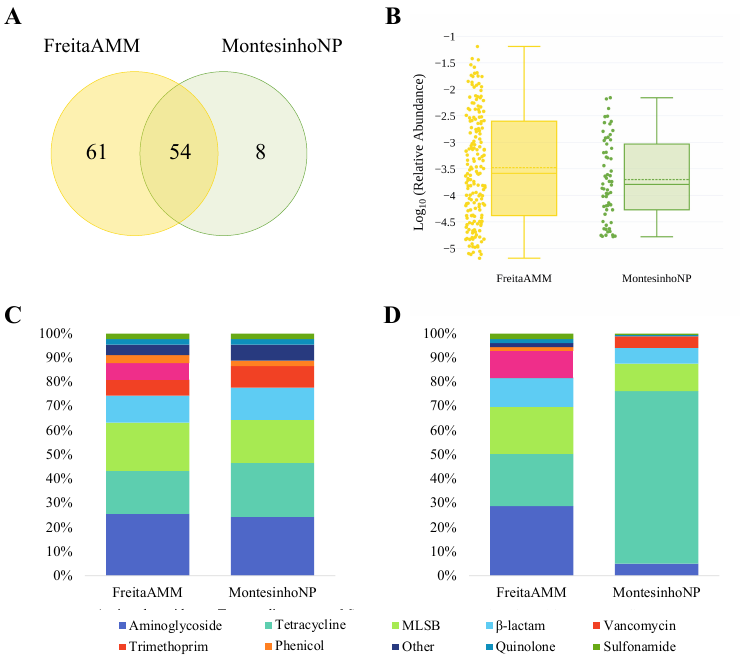
Figure 2. AMR genetic determinants identified on red fox samples based on collection site. ( A ) A Venn diagram illustrating the proportion of shared genes; ( B ) the relative abundance of genes (log 10 ); ( C ) the percentage of the variety of ARGs; and ( D ) the abundance by antibiotic class.